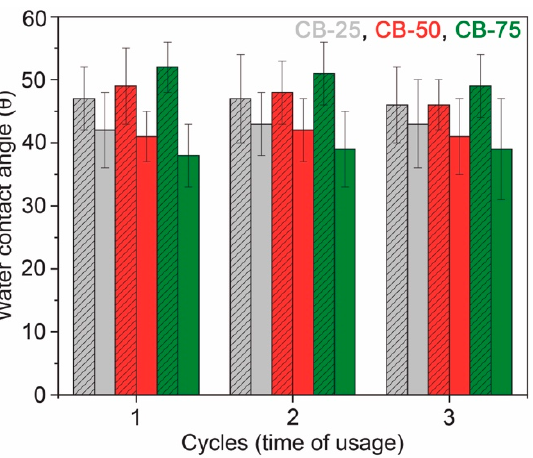
Figure 3. Water contact angles of and N-H (patterned) and N-Cl films of CB-25 , CB-50 , and CB-75 in repeated cycles.